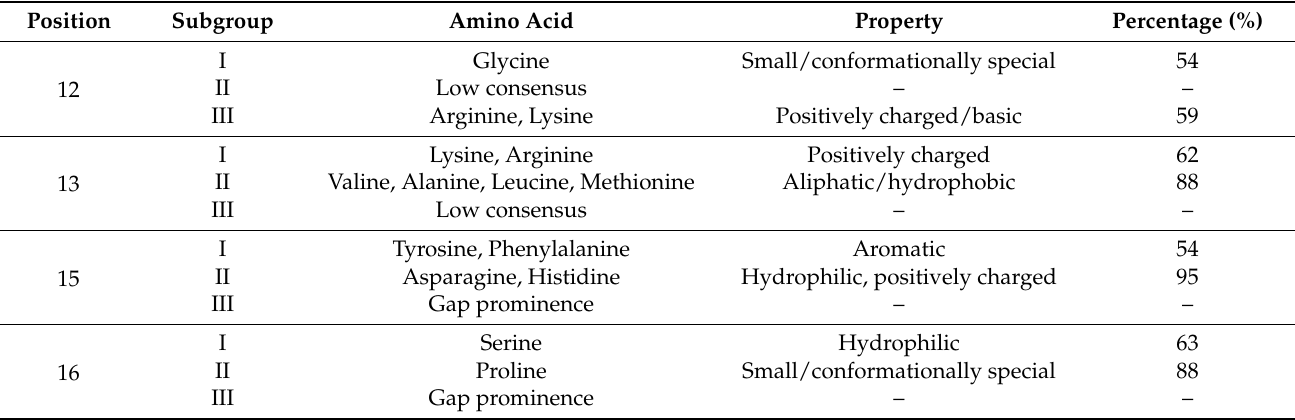
Table 4. Specificity residue identification